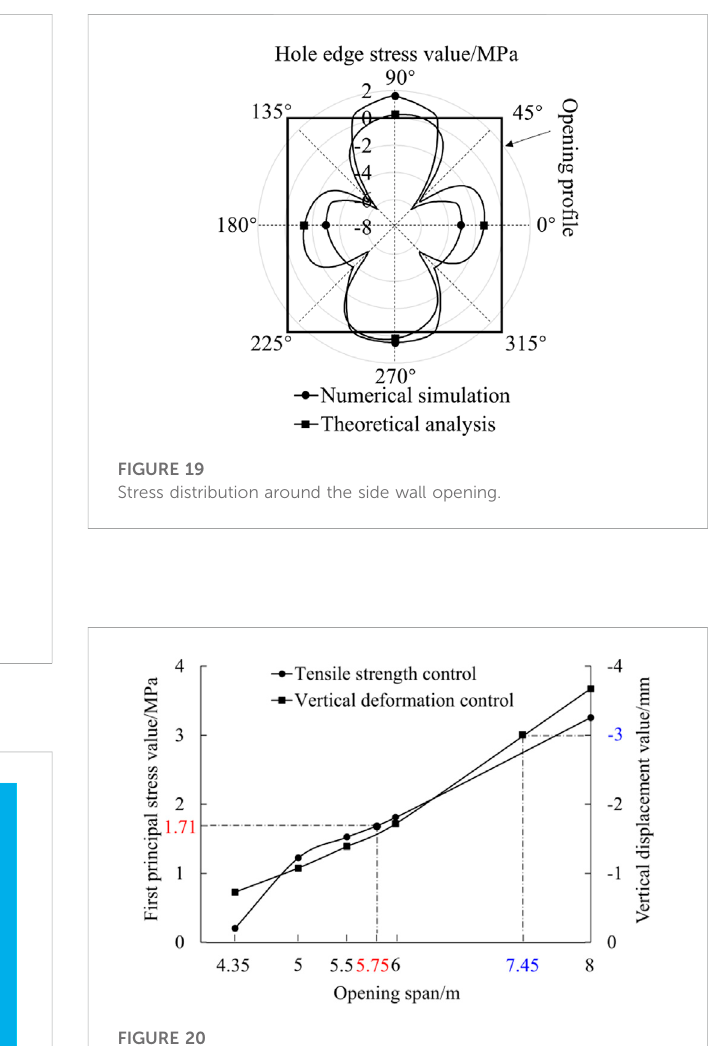
FIGURE 20 Ultimate opening span under allowable conditions.